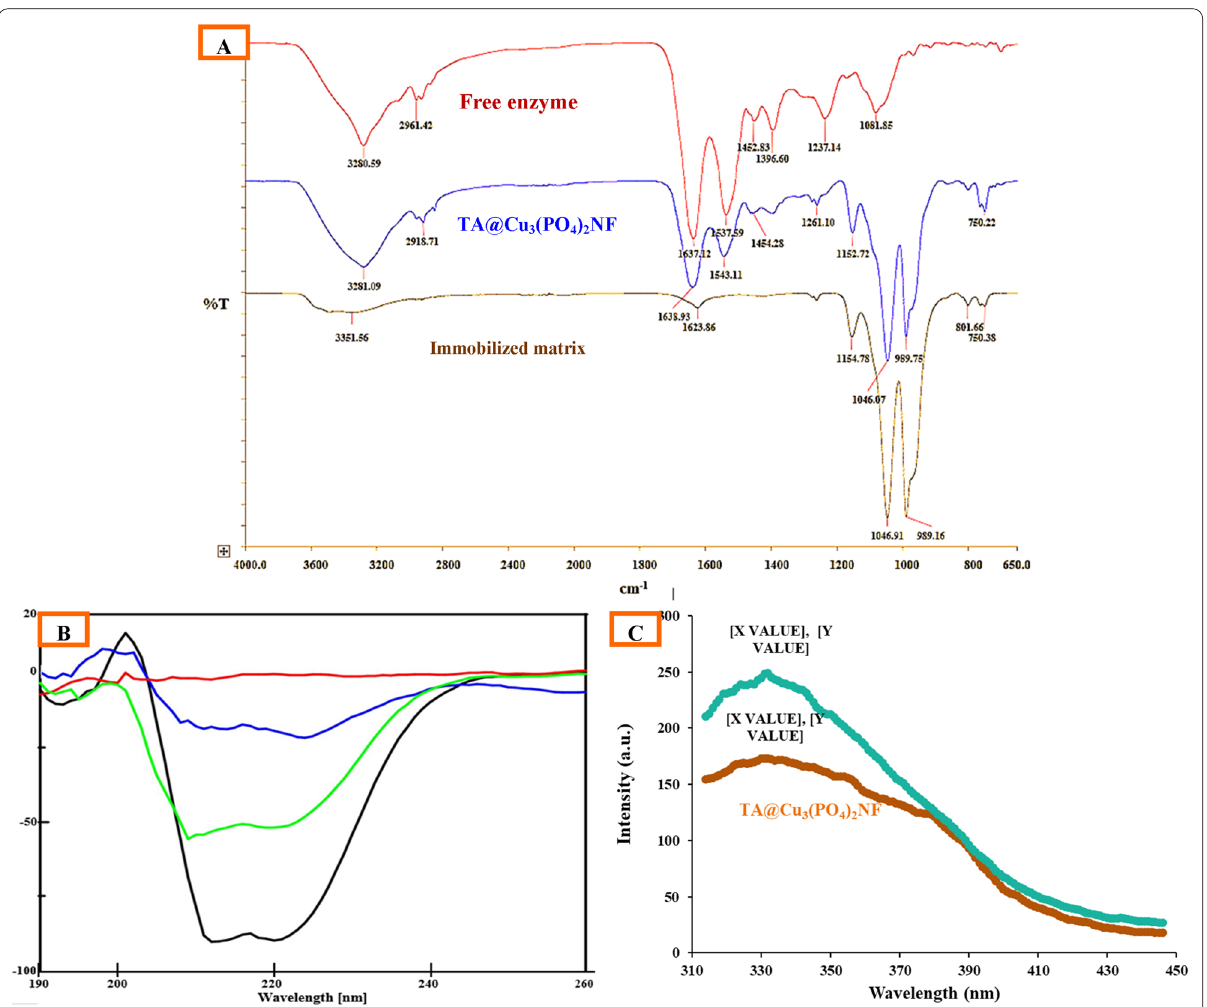
Fig. 5 A Chromatogram of ( RS )-α-MBA; B chromatogram of ( S )-α-MBA; C chromatogram for catalytic conversion of ( R )-α-MBA into acetophenone at different time